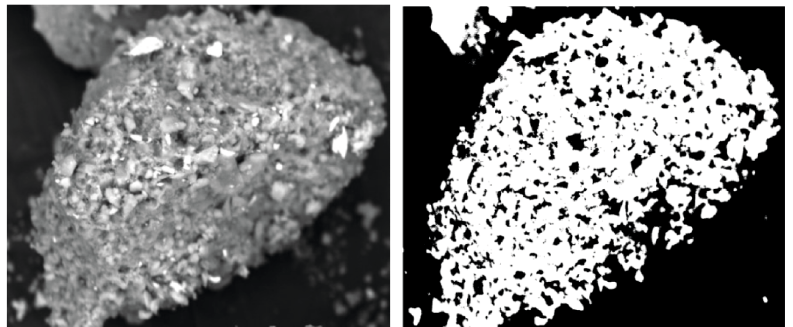
Figure 4: Scanning electron microscope images and pore identi fi cation images.